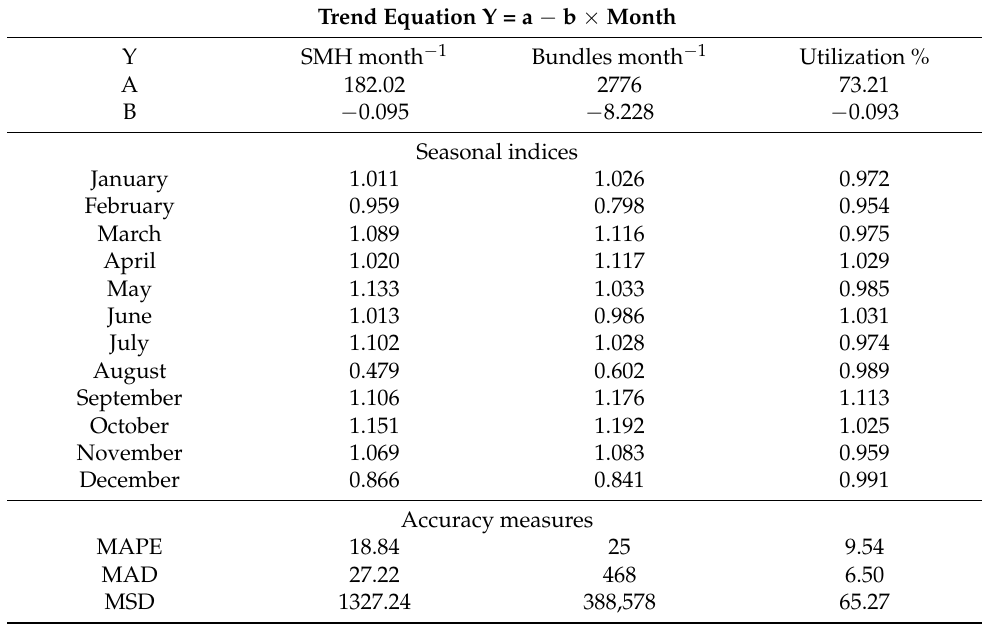
Figure 3. Monthly graph of scheduled hours, bundle production, and utilization rate. Table 4. Main statistics from the decomposition analysis of the time series.